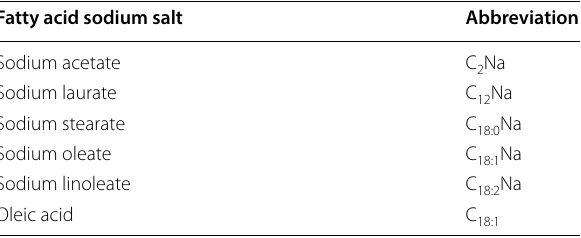
Table 1 Fatty acid sodium soaps used in this